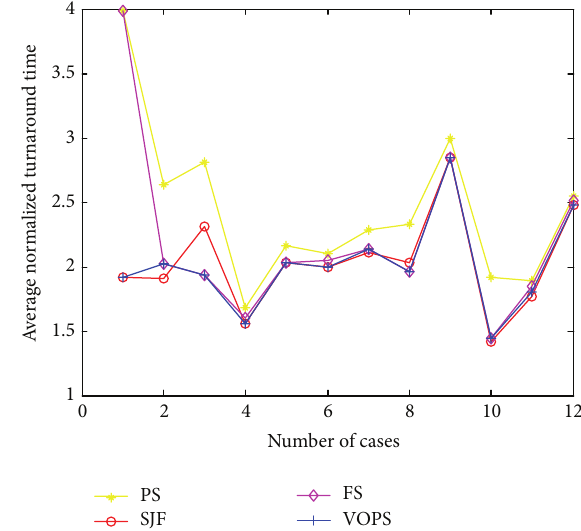
Figure 9: Average waiting time.